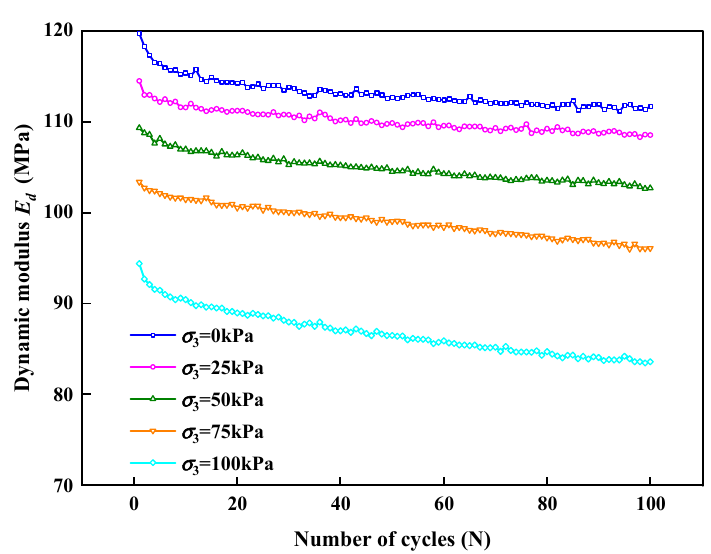
Figure 15. Variation of E d with the number of cycles applied under various σ 3 values.